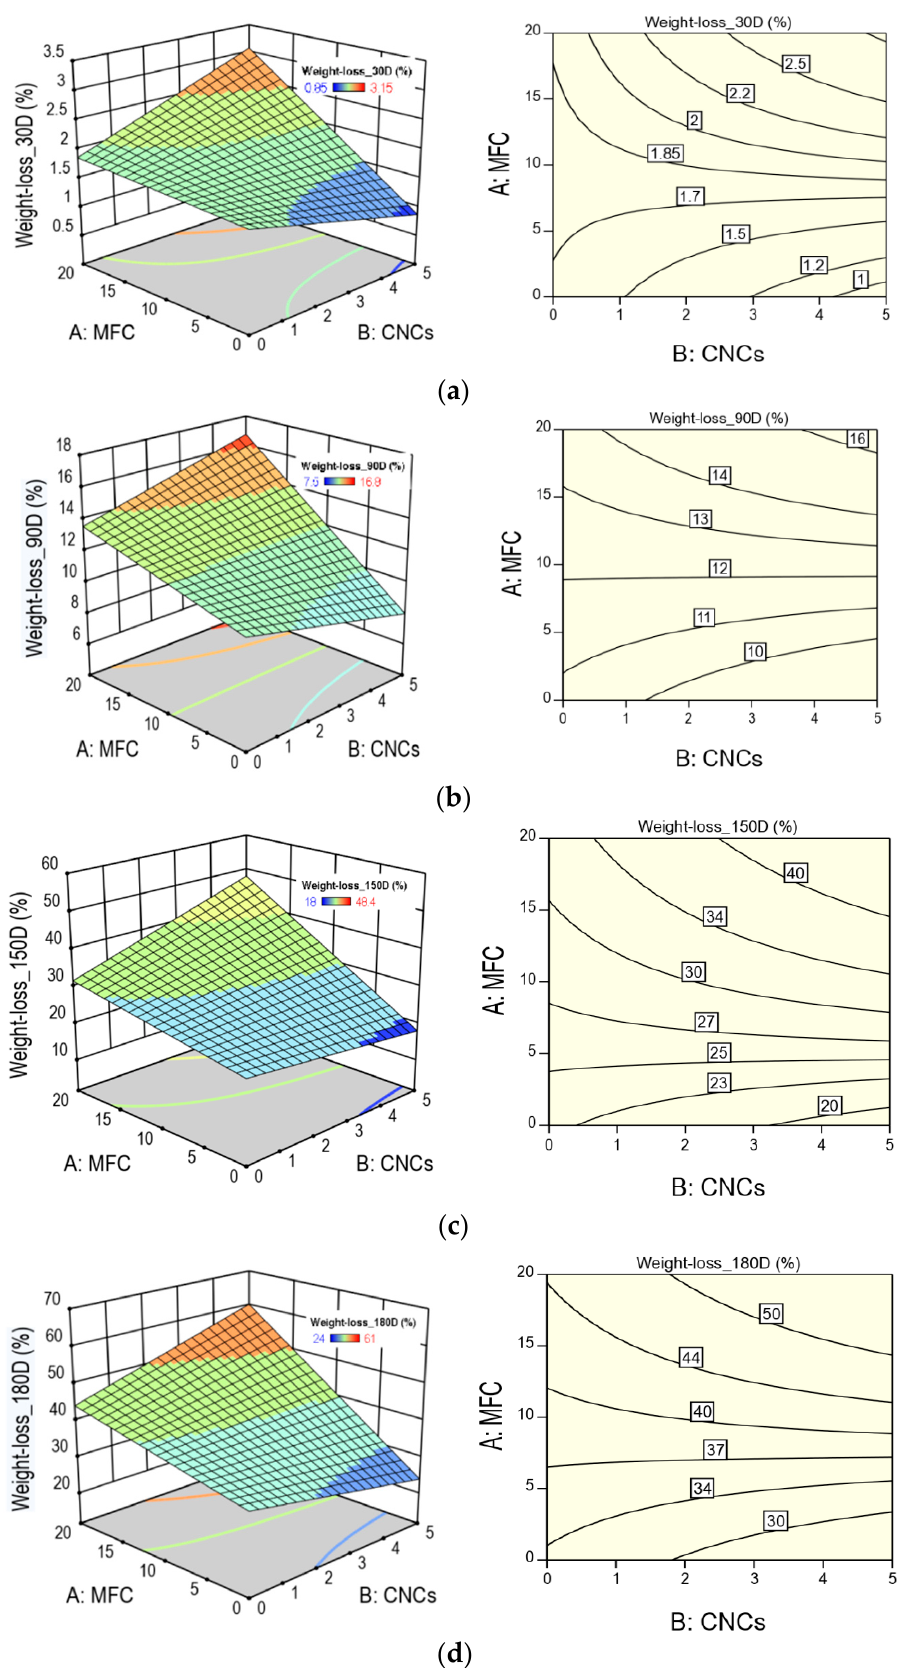
Figure 9. Surface response and contour plots for weight loss for ( a ) 30D; ( b ) 90D; ( c ) 150D; and ( d ) 180 D incubation days.